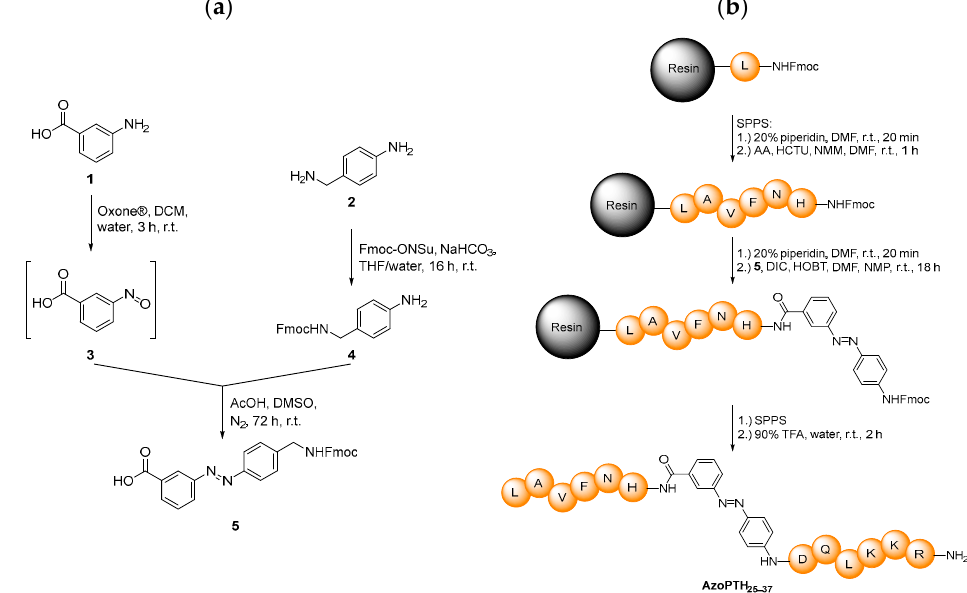
Figure 2. ( a ) Synthesis of Fmoc-protected trans -3,4 ′ -AMPB 5 . ( b ) Solid-phase peptide synthesis strategy towards the peptide AzoPTH 25–37 .